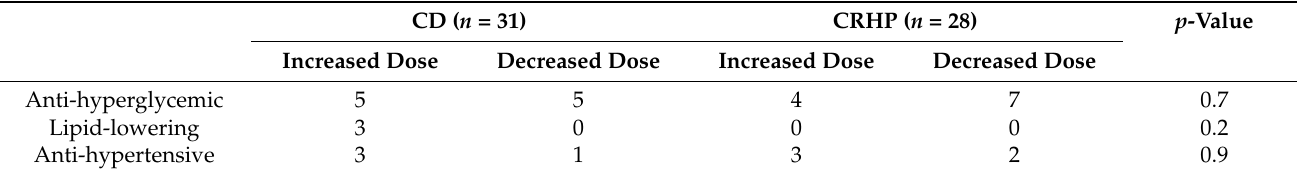
Table 4. Medication